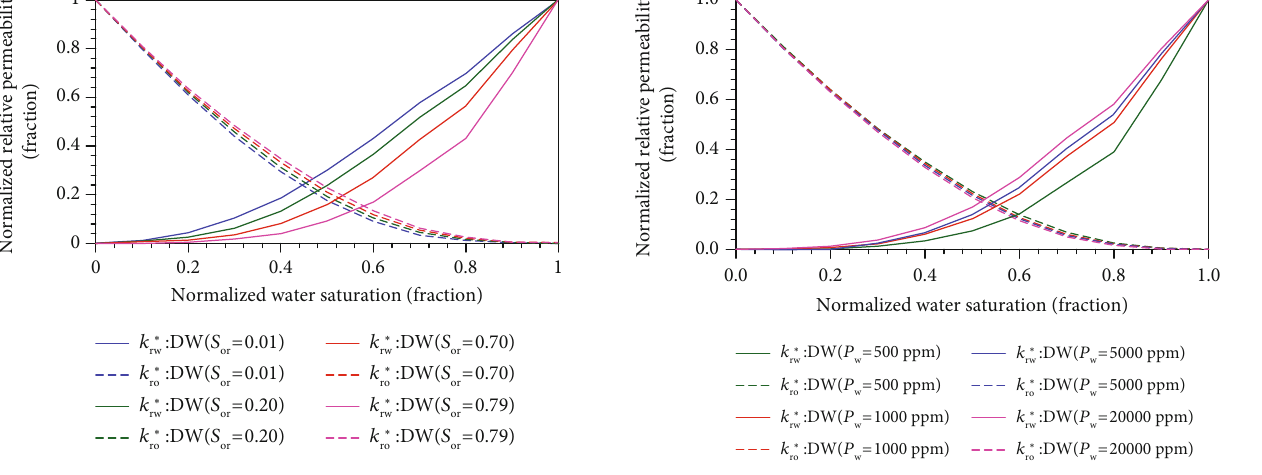
Figure 5: Normalized oil-water relative permeability curves under di ff erent P w